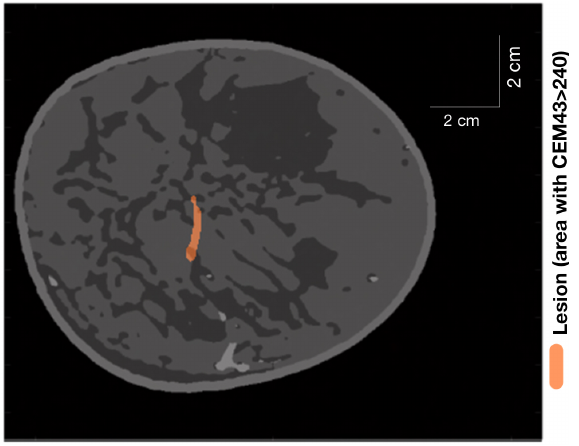
Figure 10. Lesion (area with CEM 43 > 240) generated in an extremely dense breast after turning on HIFU for 5 s and then turning it off for 1